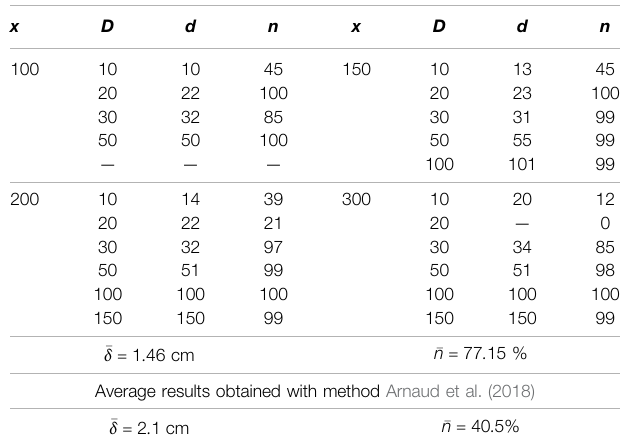
TABLE 2 | Results of the evaluation of the segmentation algorithm for 100 measures. x represents the distance between the tablet and the furthest plane, D the real distance between the two planes and d the measured one. All these distances are expressed in centimeters. n represents the number of valid measured frames for each